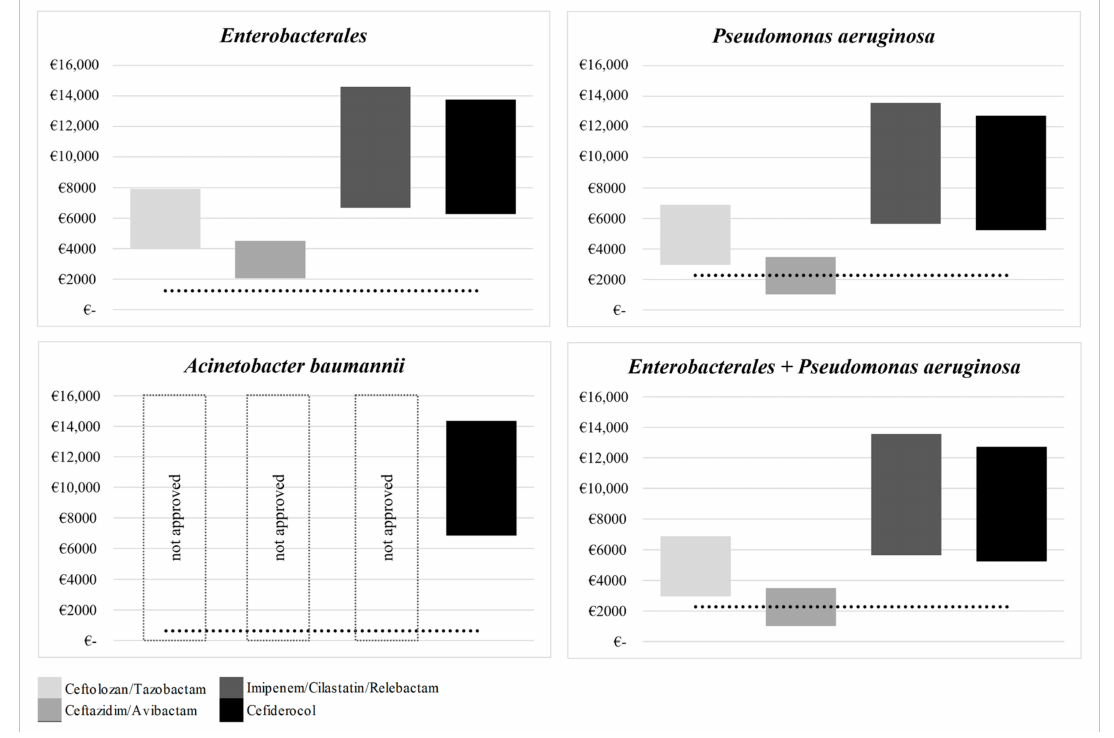
Figure 1. Drug-specific underfunding by MDR-GNB